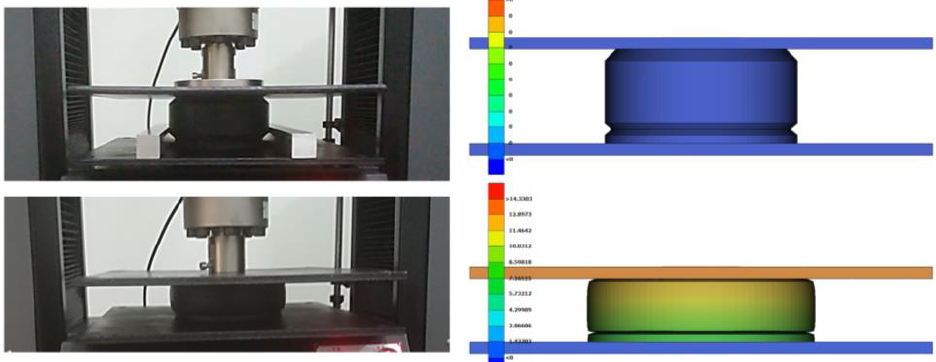
Figure 5. Comparison between experimental and numerical response at final states of compression.